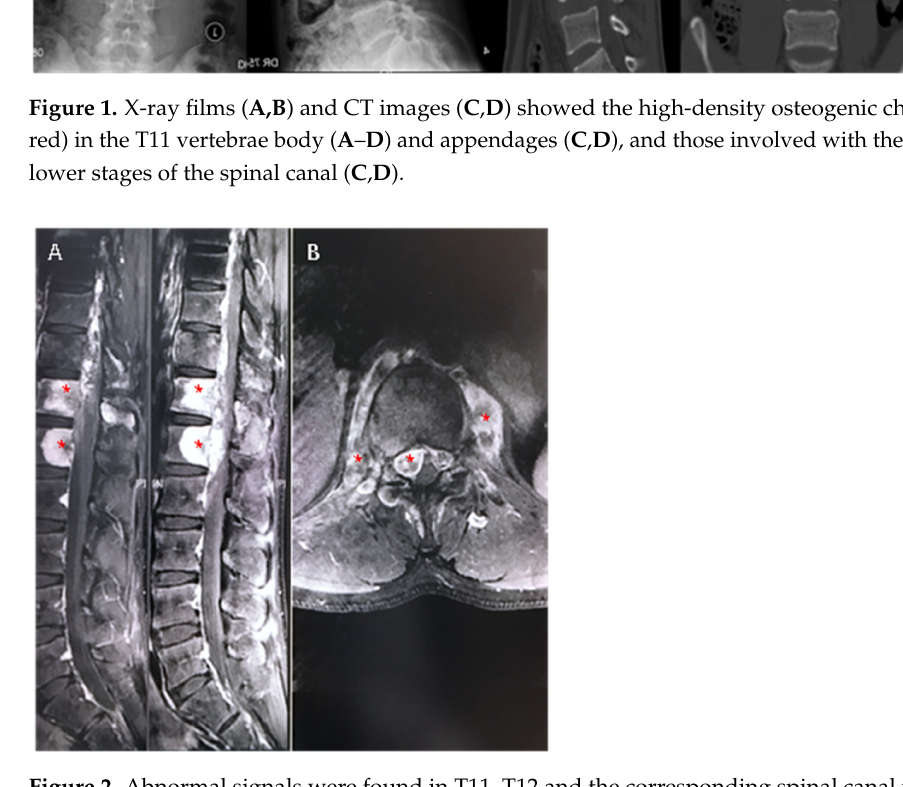
Figure 2. Abnormal signals were found in T11, T12 and the corresponding spinal canal in contrast- enhanced magnetic resonance images both in sagittal ( A ) and axial images ( B ) (T1-weighted imaging). Tissues suspected of being tumors can be significantly enhanced in MRI images (* in red). Part of the spinal canal was occupied by the lesion and the dura sac was obviously